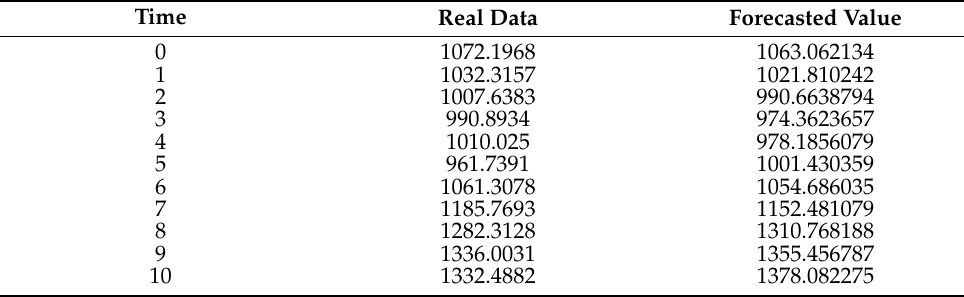
Table A1. Selected forecasting